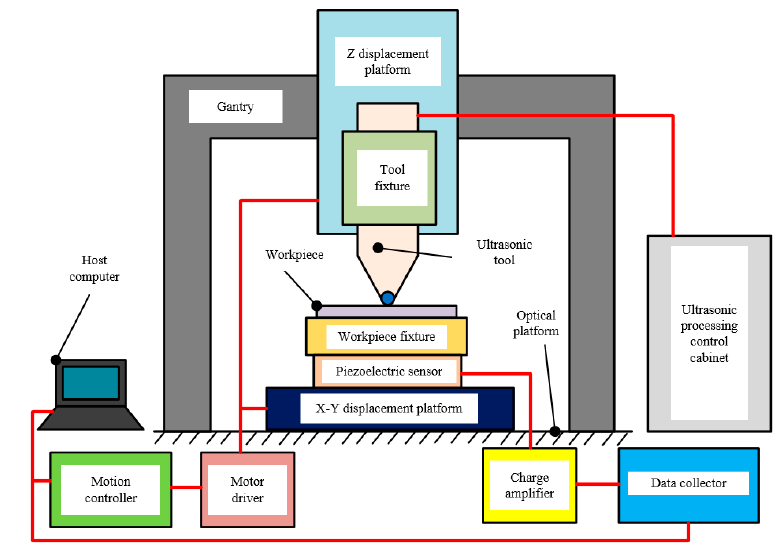
Figure 2. Configuration of the proposed UIP-based device.